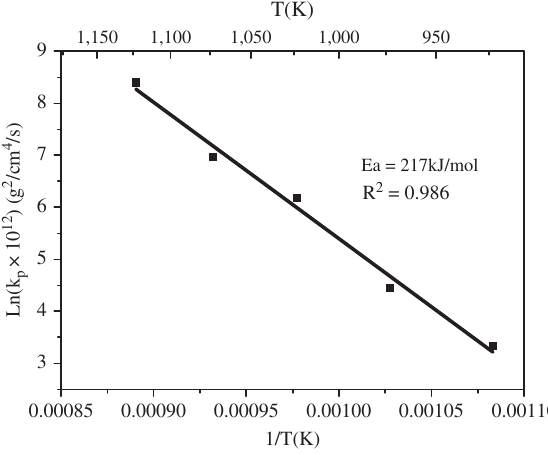
Figure 10: Arrhenius plot for the air oxidation of Ti-6Al-4V made by HIP